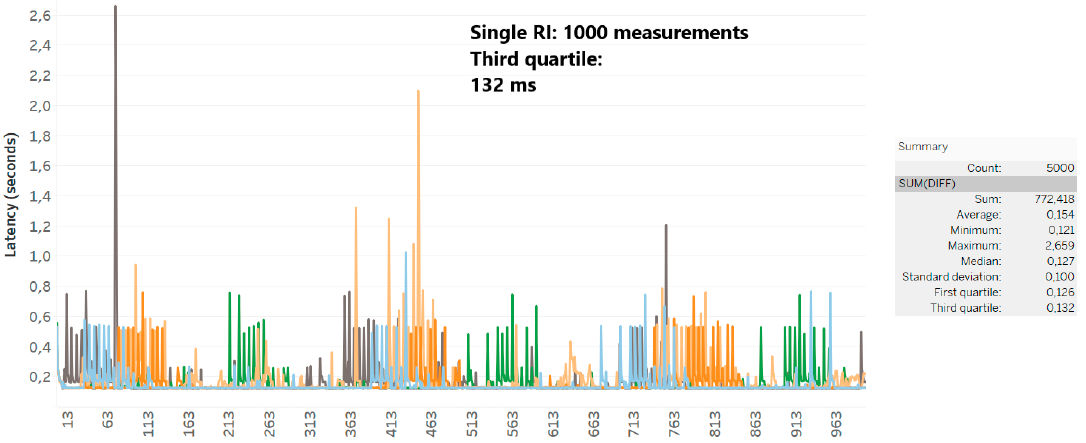
Figure 10. Single RI results for JaNDER Level 0 test: 1000 measurements for every repetition.